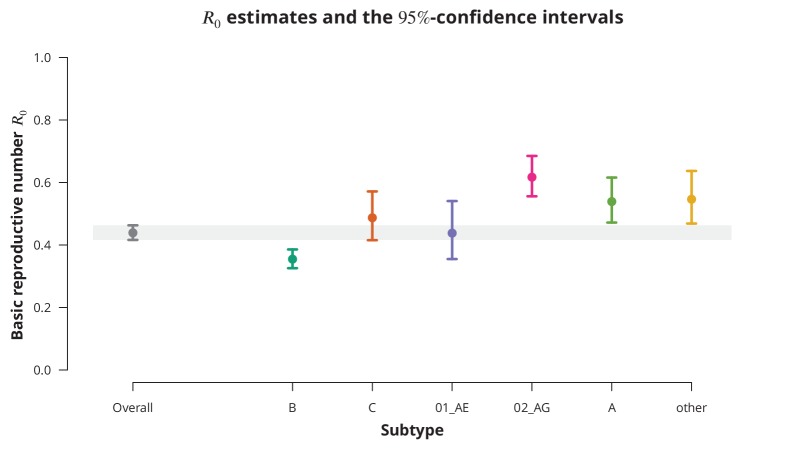
Overall basic reproductive number R0 and R0 per subtype from stratified analysis.The dark gray point indicates the overall basic reproductive number R0 estimate (by neglecting the transmission chain subtypes) and the corresponding 95%-confidence interval is shown with the dark gray line and the gray-shaded band. The analogous results from the per-subtype stratified analysis are represented by colored points and lines, each color corresponding to one of the subtypes (B, C, CRF01_AE, CRF02_AG or A) or the group of subtypes (other).